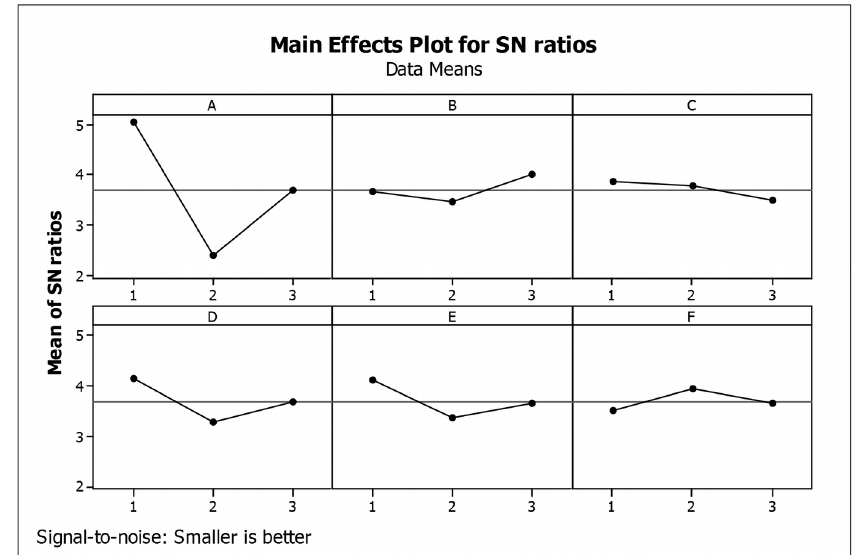
Figure 10. Average S/N rate for each level of the factors